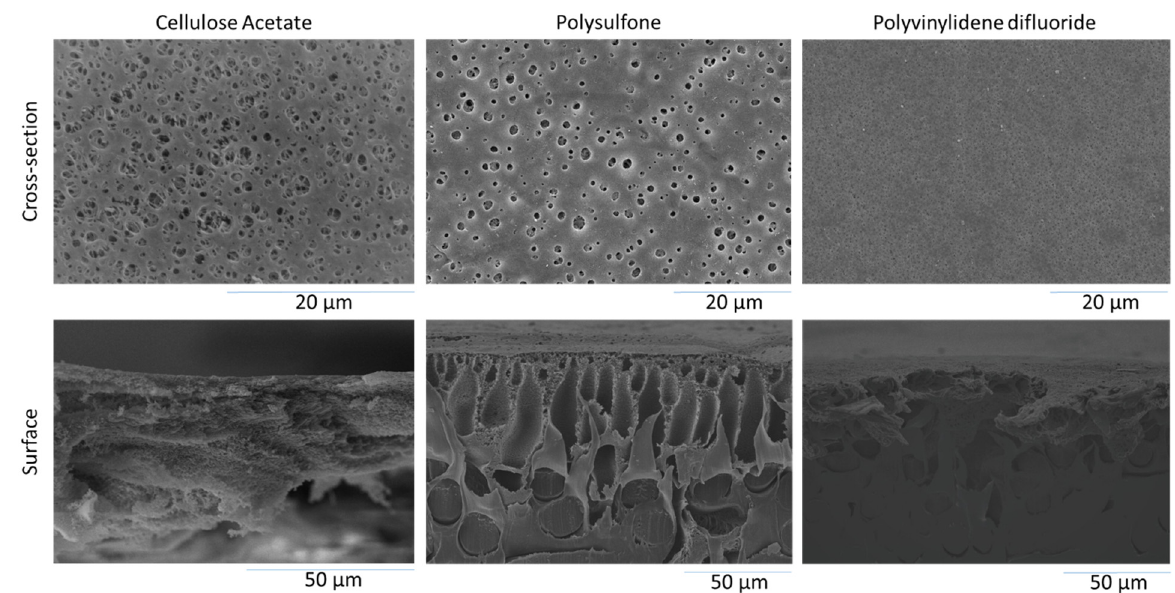
Figure 2. Surface and cross-section SEM images of the membrane samples.